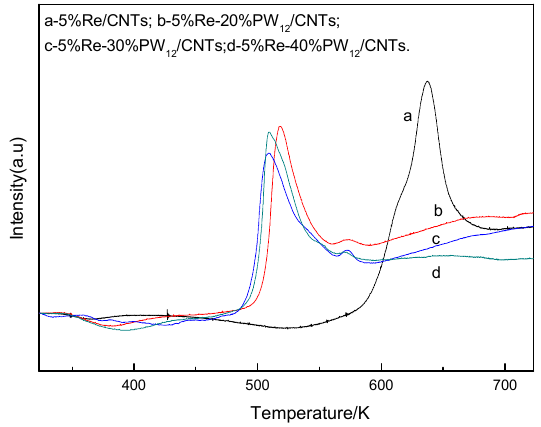
Figure 4. H 2 ‐ TPR profiles of 5%Re ‐ PW 12 /CNTs with different PW 12 content.